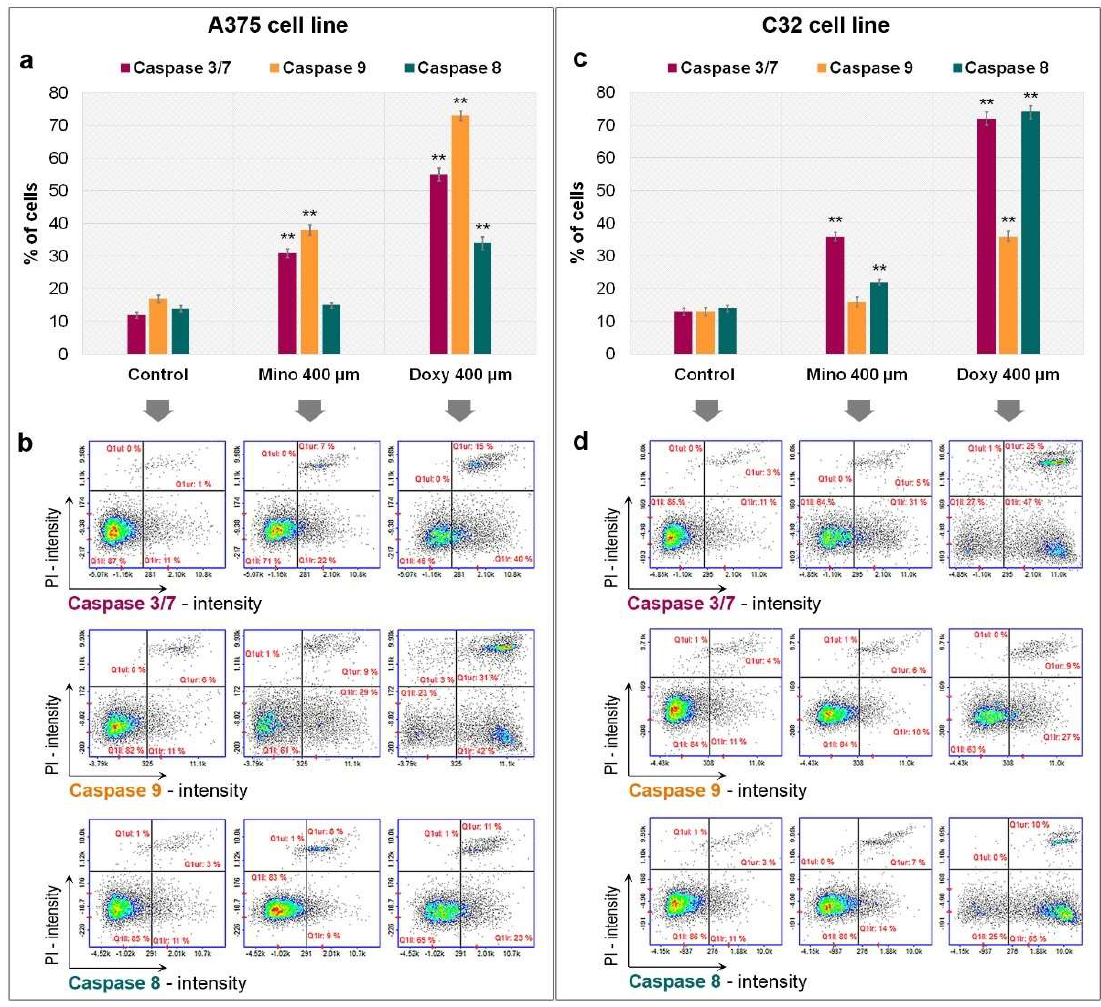
Figure 7. Analysis of caspase activity after the treatment of melanoma cells with minocycline and doxycycline. Bar graphs present the results for A375 ( a ) and C32 ( c ) cell lines. Representative scatter plots ( b , d ) present PI- and FLICA-stained cells divided by a gate into the subpopulations of cells without and with activated caspase. ** p < 0.005 vs. control.